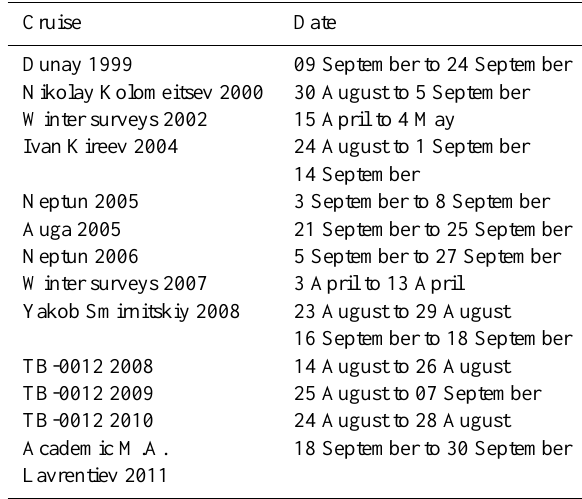
Table 1. List of summer cruises and winter expeditions (1999–